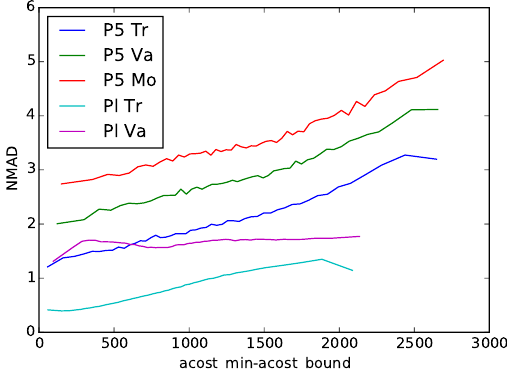
Figure 5: Dependence of height error on aspect.